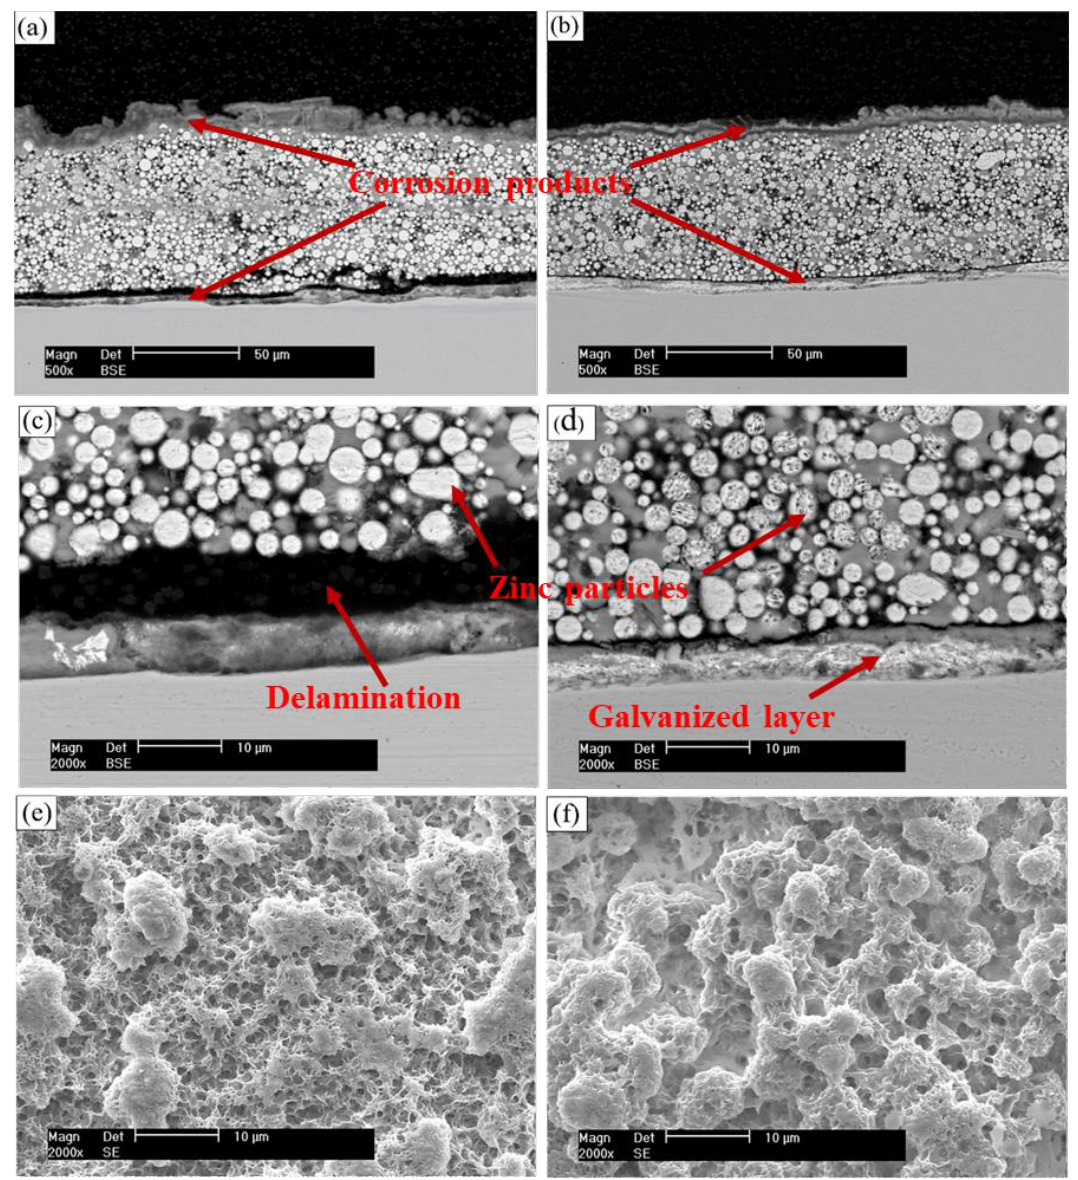
Figure 9. The cross-section SEM micrograph of the coatings after immersion in 3.5 wt % NaCl solution for 20 days: ( a , c ): CGC and ( b , d ): CPTES/CGC; and surface topography SEM micrograph of the coatings after immersion in 3.5 wt % NaCl solution for 20 days: ( e ): CGC and ( f ): CPTES/CGC.